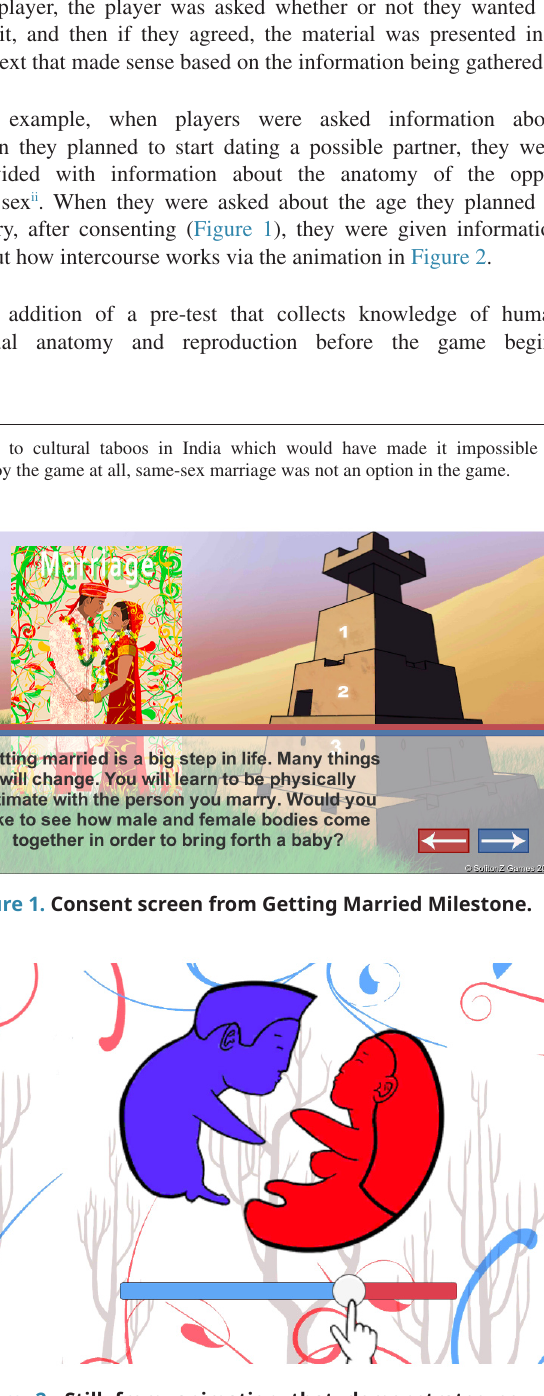
Figure 2. Still from animation that demonstrates sexual